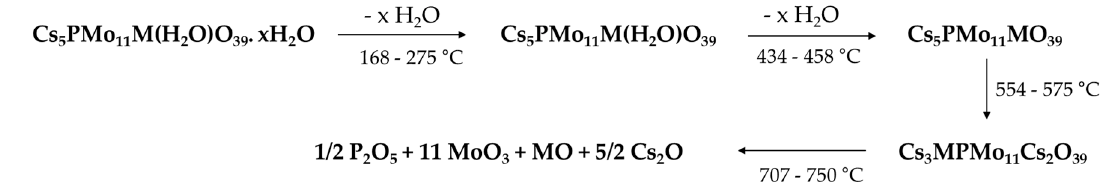
Figure 6. Proposed scheme of thermal decomposition process for POMs salts.